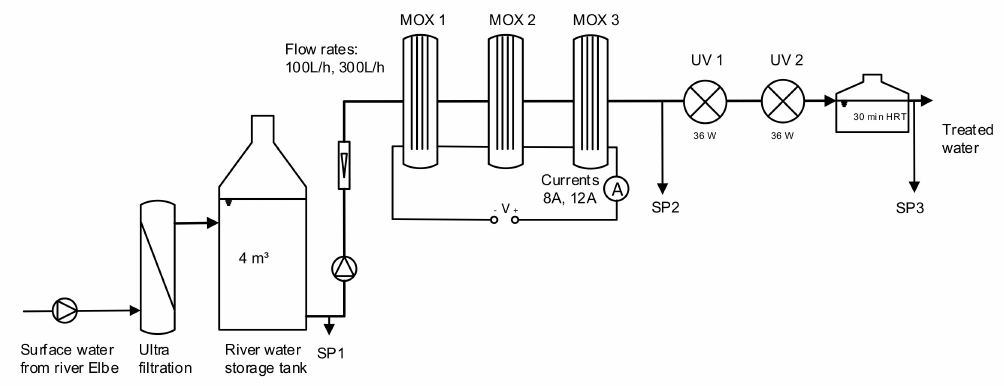
Figure 3. Pilot system tested with Elbe river